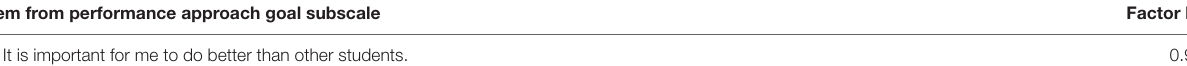
TABLE 1 | Measurement of performance approach (PAP) goals using the AGR measure (Elliot and McGregor, 2001, 501–519). Item from performance approach goal